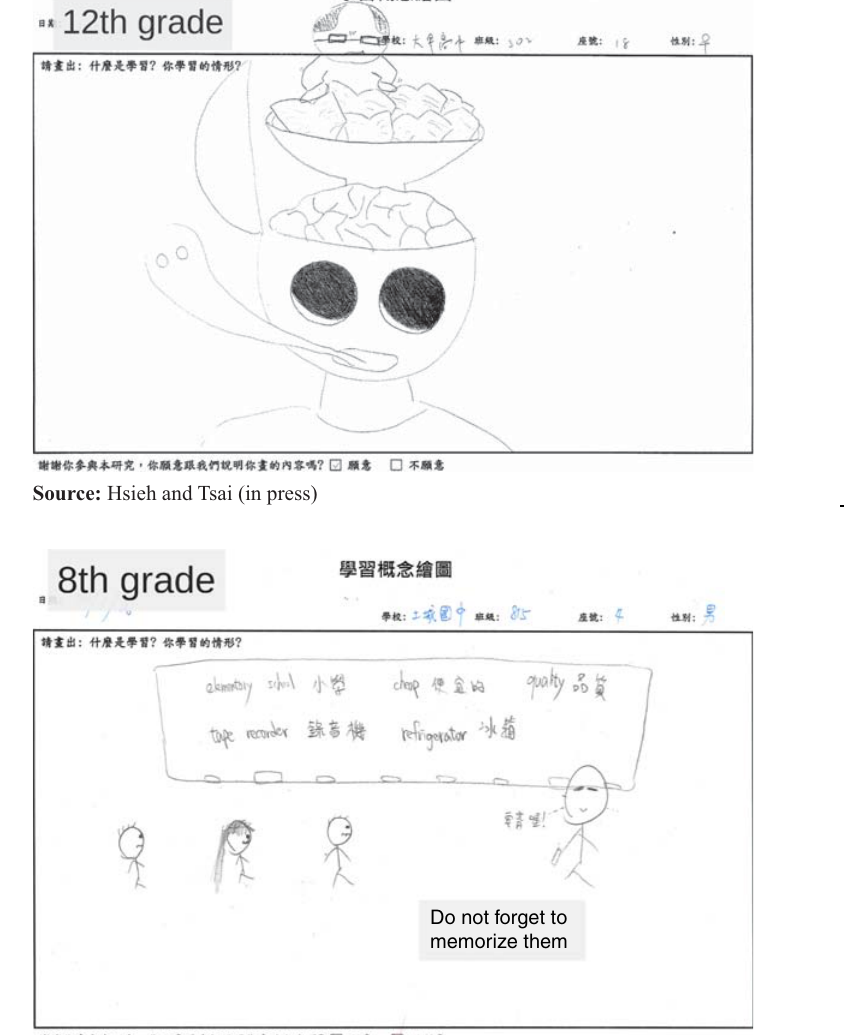
Figure 2. A drawing by an